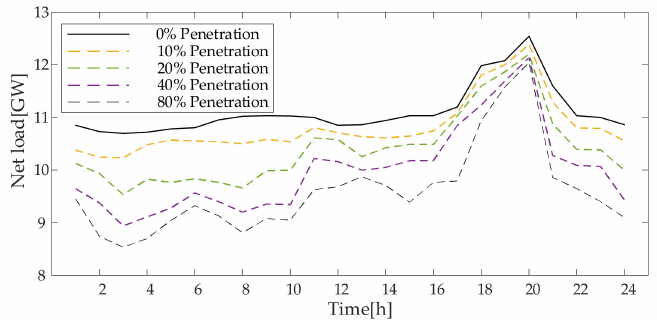
Figure 4. Net load curves with di ff erent renewable energy (RE) penetrations.